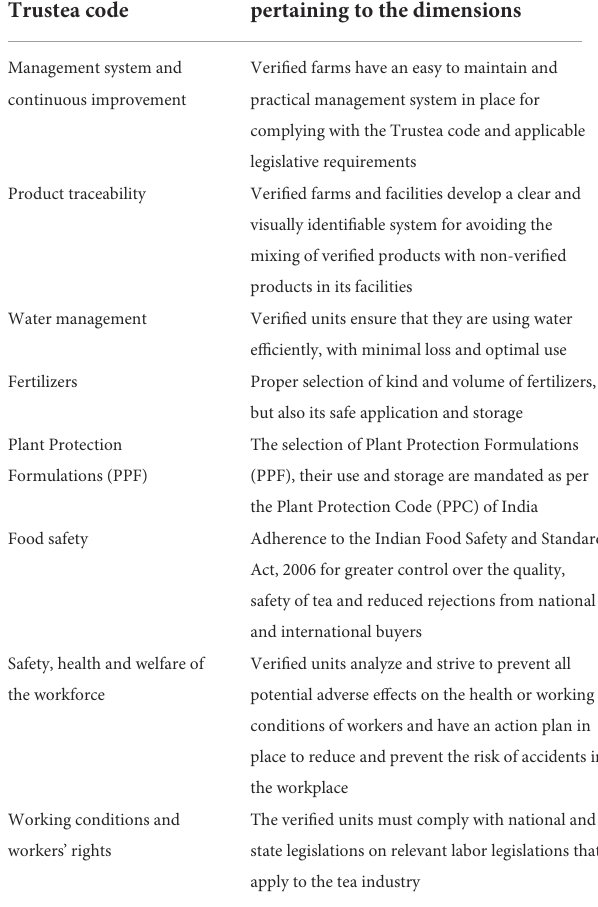
TABLE 1 Key points under the Trustea